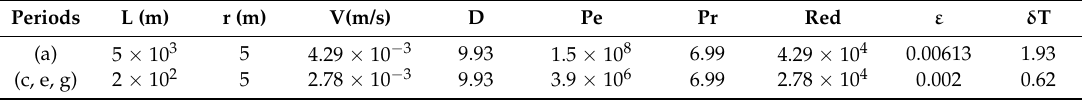
Table 5. Assessment of error due the conservative temperature assumption. Period, characteristic length, hydraulic radius, characteristic velocity, Dimensionless thermal diffusivity, Peclet number, Prandtl number, Conduit Reynolds number, dimensionless error, rescaled thermal error.